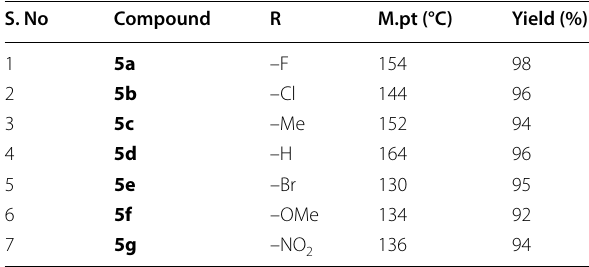
(Additional file 1: Table S2). Thus we concluded that the- oretical calculations, experimental results and literature proved that E , s - cis conformation was predominant con- formation over E , s - trans conformation.